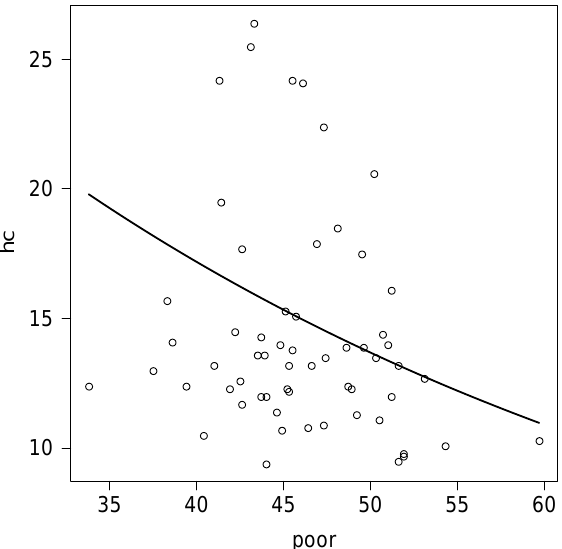
Figure 2. Plots for poor versus hc and the estimated conditional mean for the RPa regression